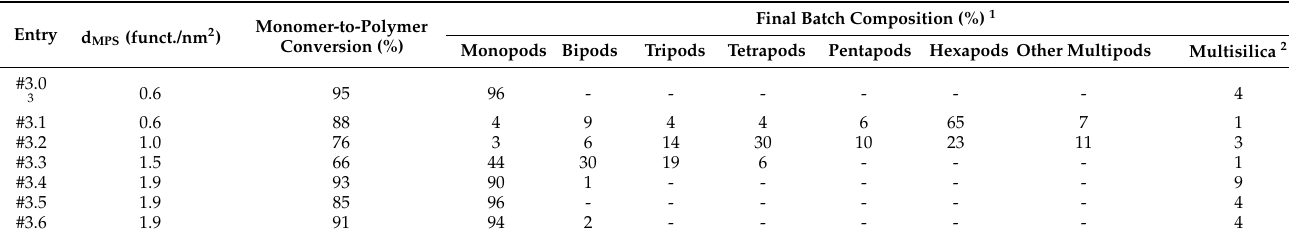
Table 3. Morphological distribution and geometrical parameters of the magnetic silica/PS particles as a function of the nominal grafting surface density d MPS . Experimental conditions: [100-nm silica] = 4.8 × 10 14 part./L; [styrene] = 56.8 g/L; [Synperonic ® NP30] = 0.19 g/L; [SDS] = 0.01 g/L; [Na 2 S 2 O 8 ] = 0.78 g/L; 70 ◦ C and 6 h. Representative TEM images are shown in Figure S4 for entries #3.1, #3.2 and #3.4.